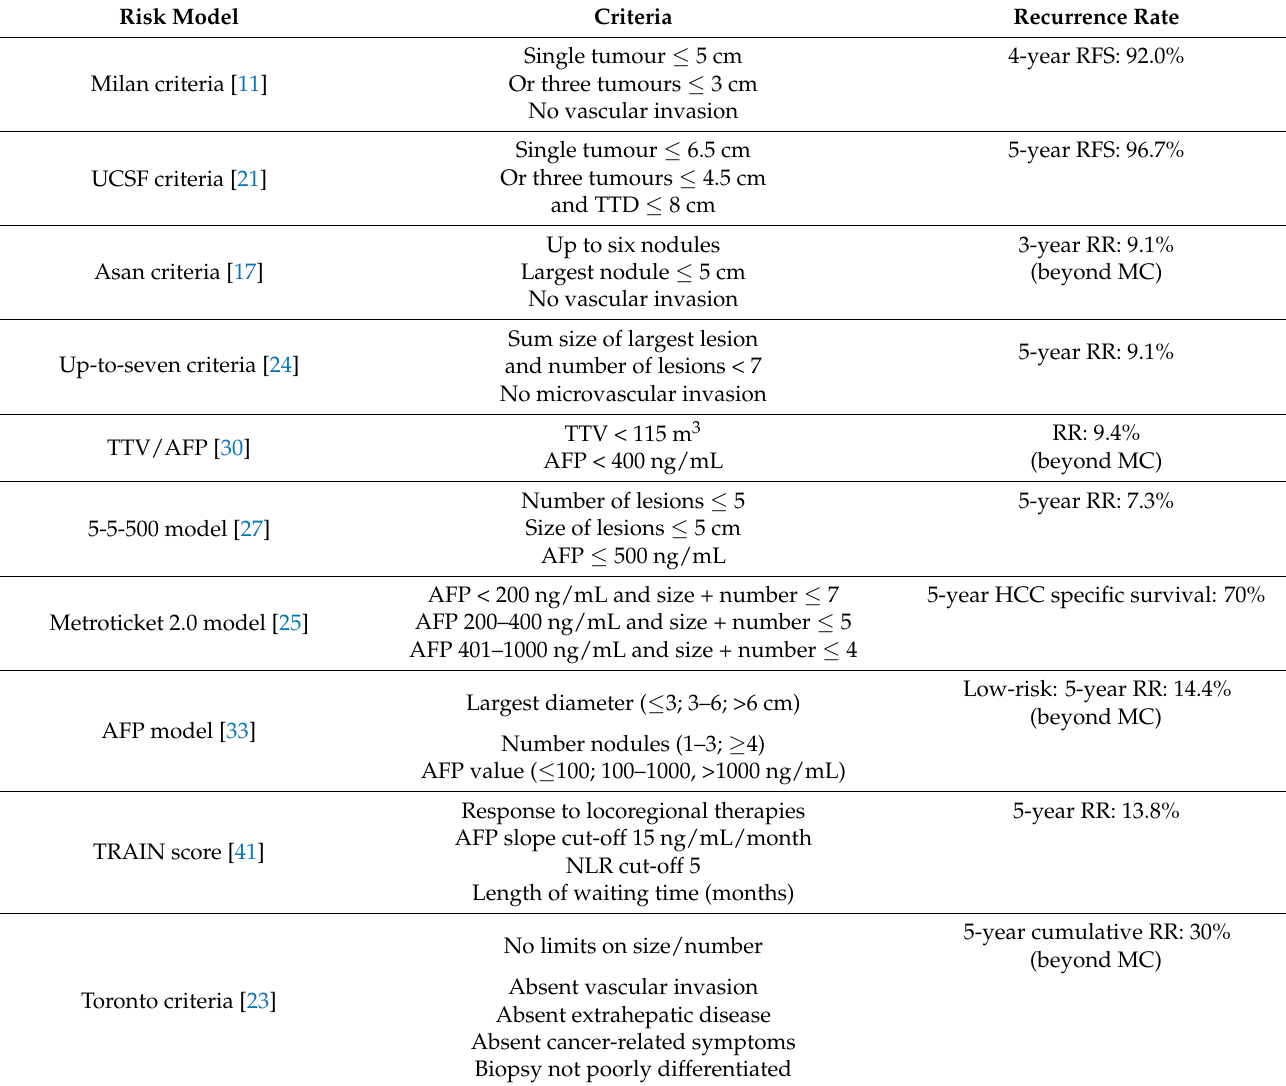
Table 1. Pre-transplant recurrence risk